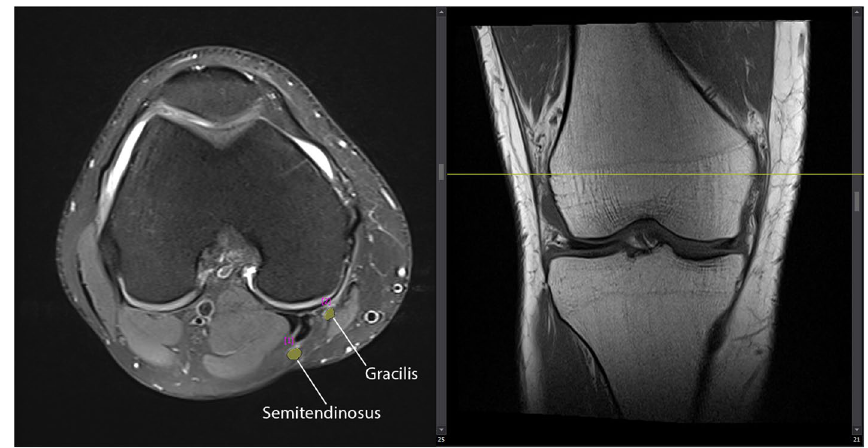
Fig. 1 Coronal sequence (right) was used to indicate the medial epicondyle of the distal femur as a reference where the CSA was measured on axial sequences